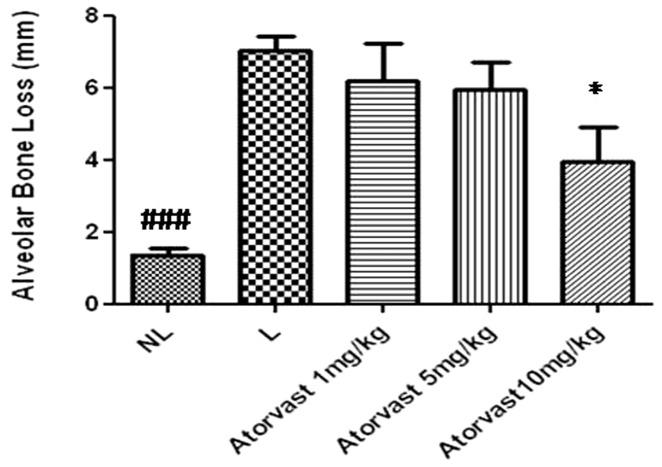
Effect of Atorvastatin treatment on alveolar bone loss associated with experimental periodontitis Disease (EPD) in rats.Values are expressed as means± SEM (###p<0.001, *p<0.05; determined with ANOVA and Tukey'stest).